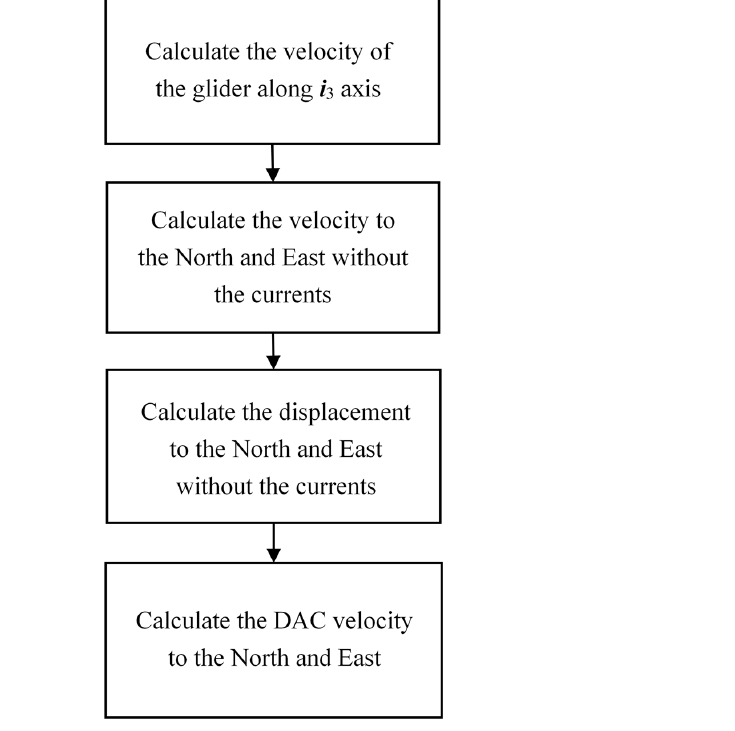
Figure 5. Calculation process of the velocity of the DAC in the horizontal